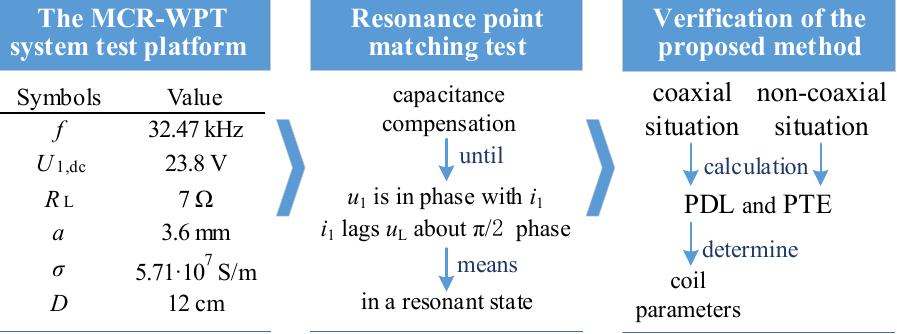
Figure 7. The flow chart of model validation.